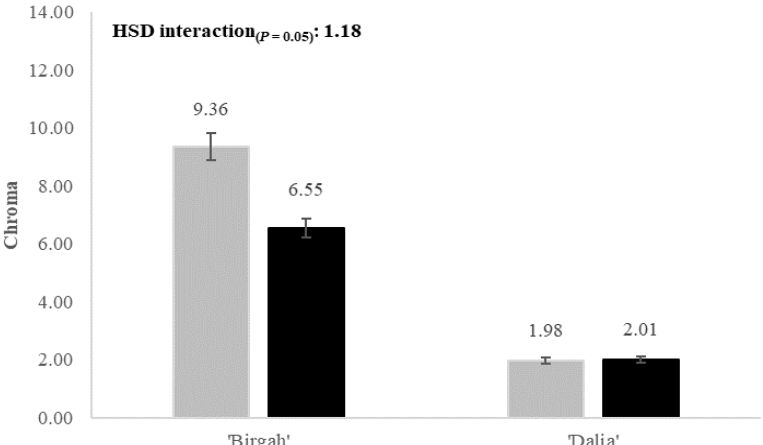
Figure 3. Fruit chroma as affected by ‘phosphorus level × cultivar’ interaction. Light grey bars: P 30 ; black bars: P 90 .